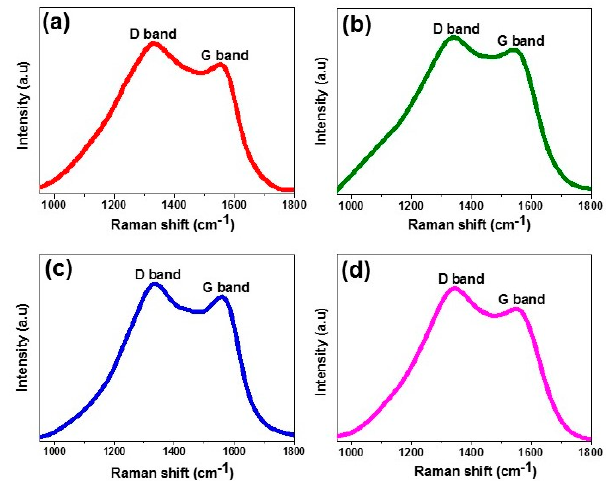
Figure 4. Raman spectra of ( a ) pear CD, ( b ) avocado CD, ( c ) kiwi CD and ( d ) citrate CD.